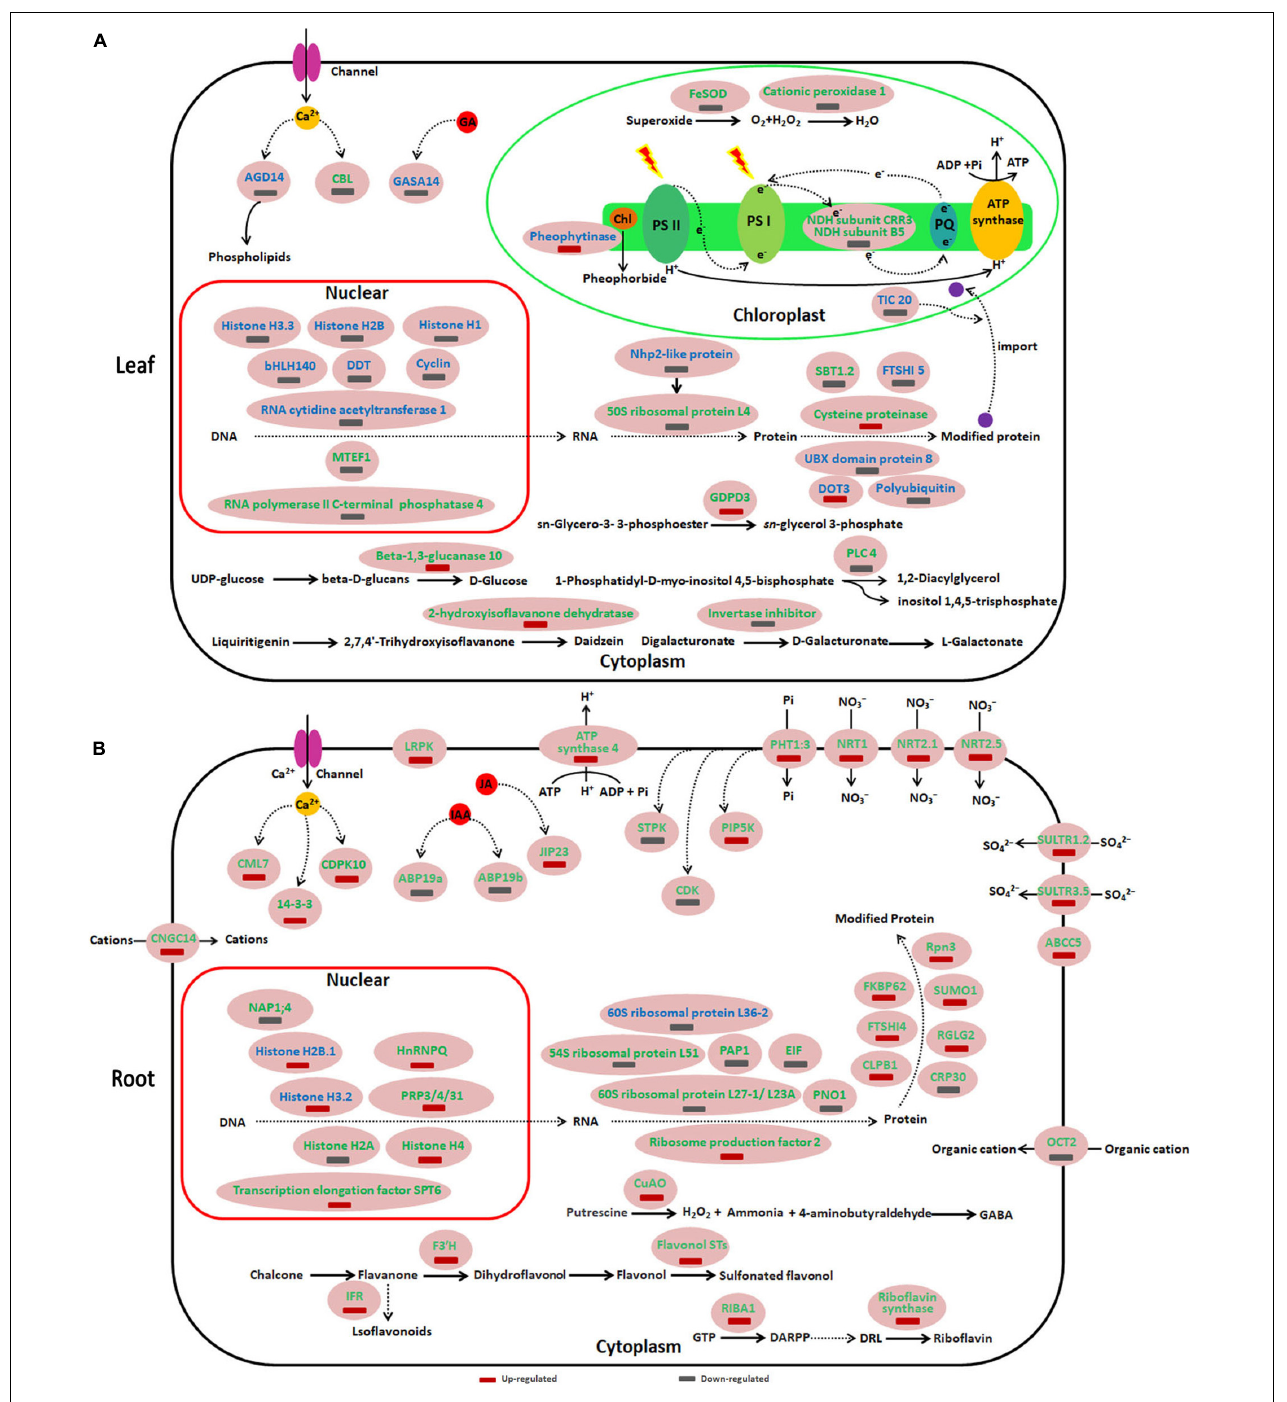
FIGURE 5 | Schematic presentation of key differentially expressed proteins (DEPs) involved in different responses of sugar beet to acid and alkaline pH environment. (A,B) represent the DEPs in leaves and roots, respectively. Blue highlighted proteins indicate only increased or decreased in the group of 9.5 vs. pH 7.5. The green highlighted proteins indicate only increased or decreased in the group of 9.5 vs. pH 7.5. ABCC5, ABC transporter C family member 5; ABP19b, Auxin-binding protein19b; AGD14, ADP-ribosylation factor GTPase-activating protein; ARPP, 5 (cid:48) -phosphate; 5-amino-6-ribosylamino-2,4(1H,3H)-pyrimidine DRL, 5 (cid:48) -phosphate; 6,7-dimethyl-8-ribityllumazine; CBL, Calcineurin B-like protein; CDK, cyclin-dependent serine/threonine-protein kinase; CDPK10, Calcium-dependent protein kinase 10; CML7, Calmodulin-7-like; CNGC14, Cyclic nucleotide-gated ion channel 14; CRP30, F-box protein CPR30 isoform X1; CuAO, copper-containing amine oxidases; CLPB1, Chaperone protein ClpB1; DARPP, ARPP, 2,5-diamino-6-ribosylamino-4(3H)-pyrimidinone; DOT3, BTB/POZ domain-containing protein DOT3;